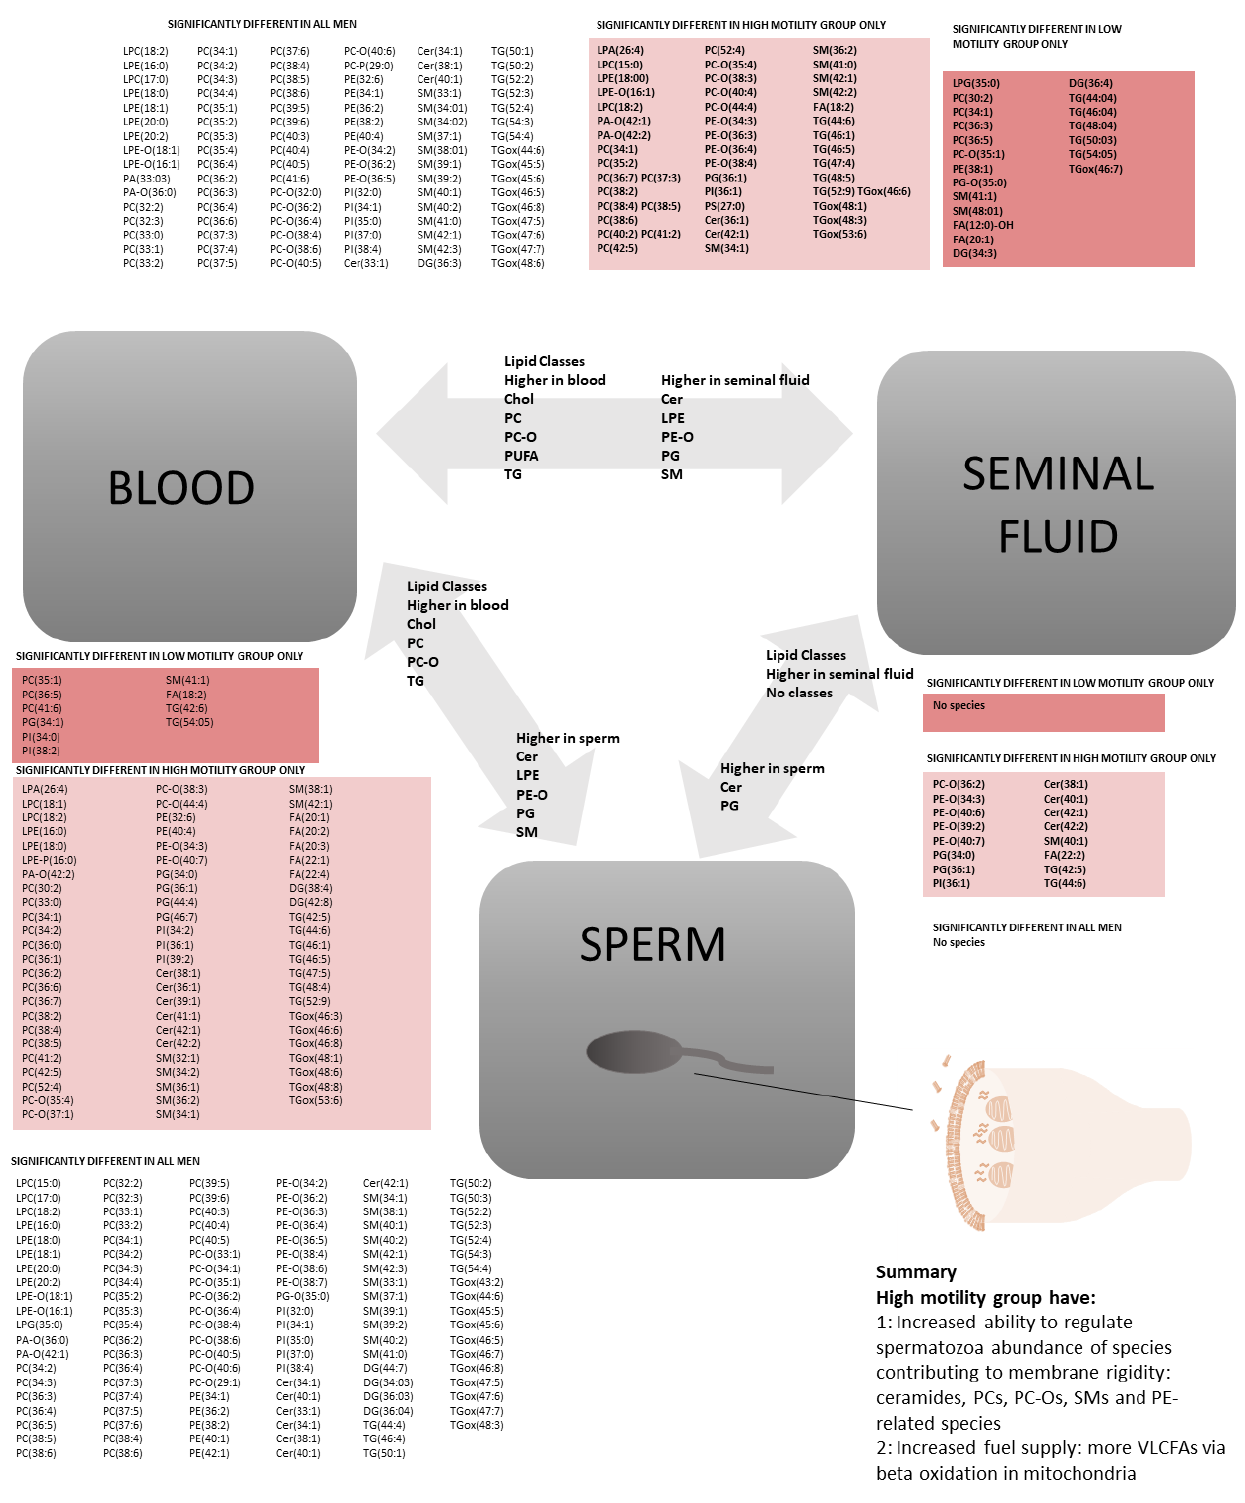
Figure 3. Significant differences in individual lipid species in association with motility group between compartments. Grey arrows: summary of significant differences in lipid classes between